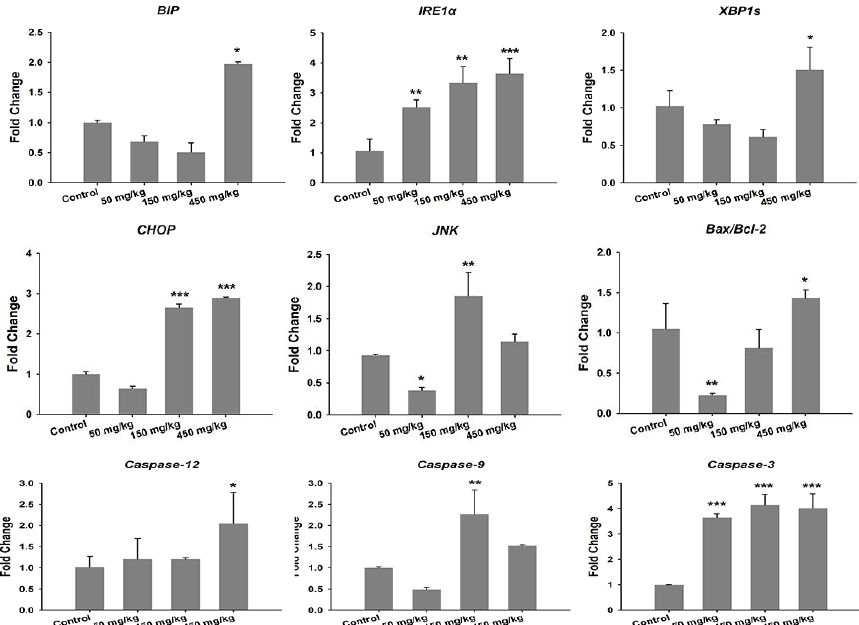
Figure 41. The effects of orally administered ZnO NPs of different doses on mRNA expression levels of ER stress, and apoptosis-related genes as determined by real-time polymerase chain reaction (RT-PCR). The JNK and caspase-12 expression levels in the testis are determined with immunofluorescence assay. The data are presented as mean ± standard deviation. * p < 0.05 vs. control, ** p < 0.01 vs. control, and *** p < 0.001 vs. control. Reproduced from [188] under the terms of Creative Commons Attribution license.